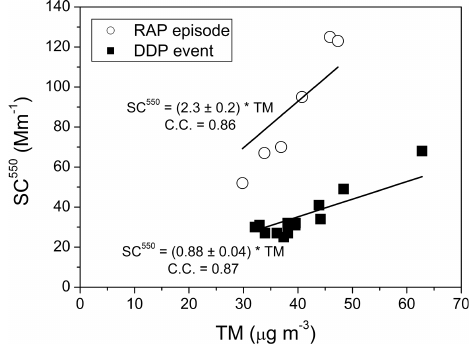
Fig. 14. Relation between SC 550 y total mass (TM) concentration (as evaluated from the volume size distribution and assuming a par- ticle density of 2gcm − 3 ), during a Regional Anthropogenic Plume (RAP) episode and the Desert Dust Plume (DDP) event over ARN